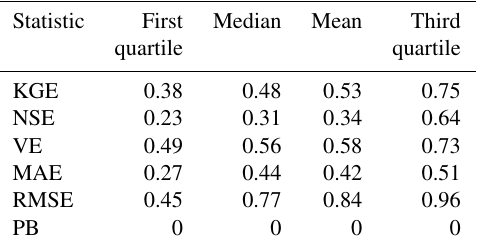
0.51 mm d − 1 (normalized flow), the RMSEs between 0.45